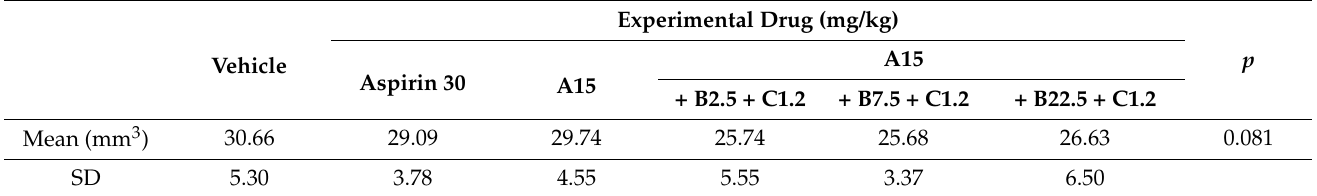
Table 7. Effects of Sample A + B + C on infarct volume after pMCAO ( n = 8–10 mice for each group).